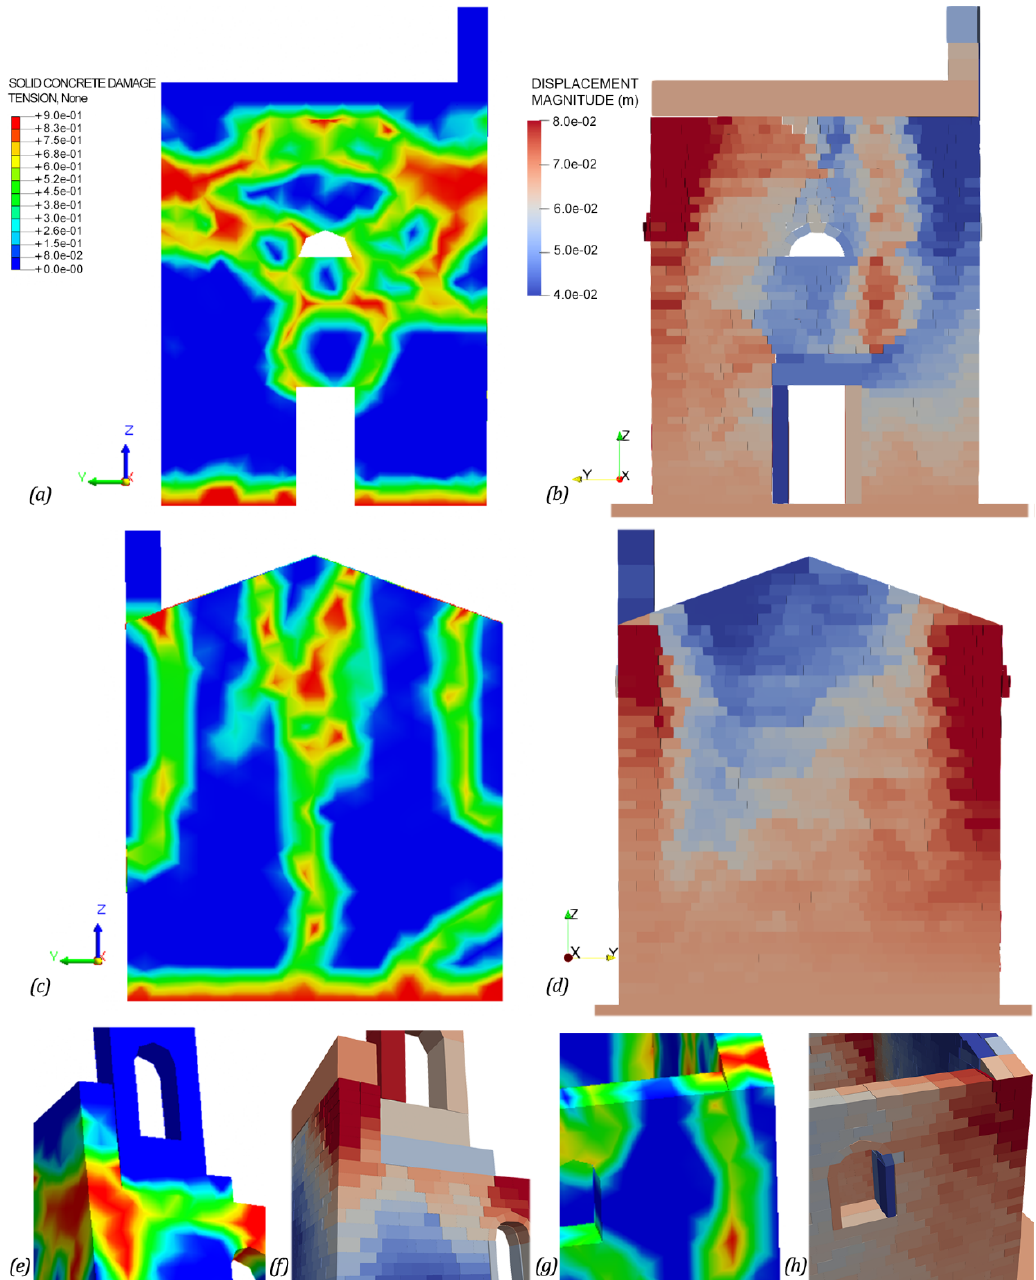
Figure 13. Views of the church final damaged configurations from the nonlinear dynamic analyses performed under the seismic actions near the structure by means of ( a , c , e , g ) the CDP model in terms of tension and ( b , d , f , h ) the NSCD method in terms of displacement respectively for the main (east) façade, the west façade, the east-north corner with the steeple, and the north-west corner.